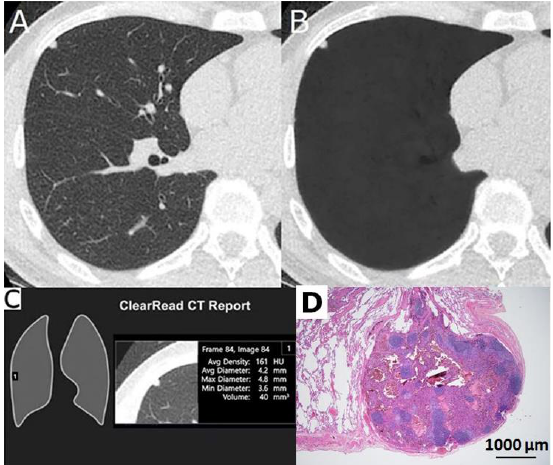
Figure 2. A 44-year-old male with a 4.2 mm well defined solid nodule with smooth outline due to intrapulmonary node in right middle lobe (RML). ( A ) Low-dose computed tomogram and ( B ) its vessel-suppressed image showed a 4.2 mm solid sub-pleural nodule in RML. ( C ) Vessel-suppressed and computer-aided detection artificial intelligence system alerted it as an actionable nodule. ( D ) Microphotograph of the specimen showed an intrapulmonary node (hematoxylin and eosin stain, ×